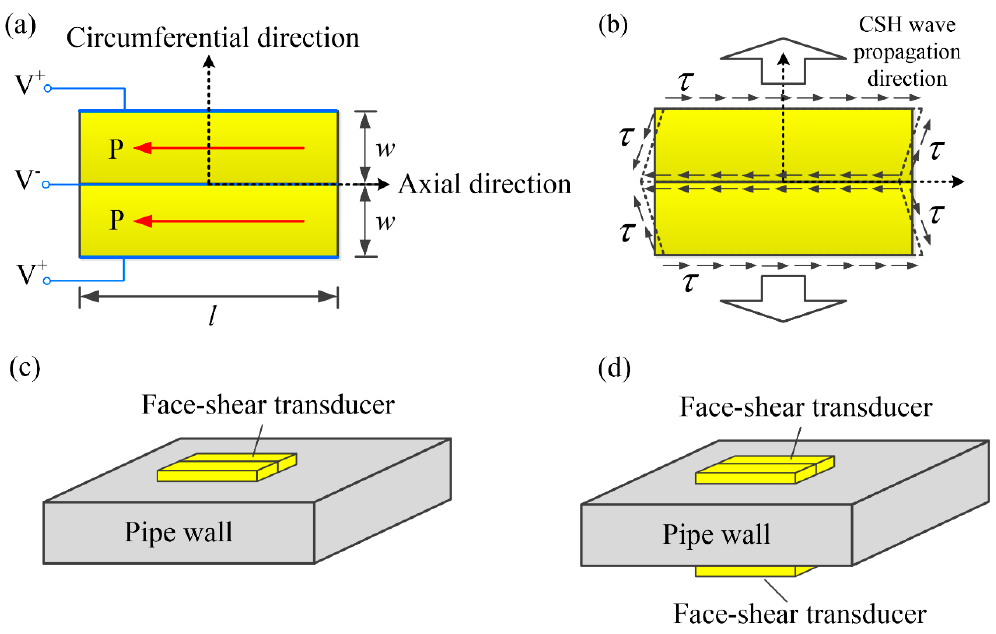
Figure 4. ( a ) Schematics of the proposed bidirectional CSH wave piezoelectric transducer, ( b ) bidirectional CSH wave driving mechanism, ( c ) single transducer configuration for pure CSH 0 wave excitation below the first cutoff frequency and ( d ) dual transducer configuration for selectively exciting CSH 0 or CSH 1 wave above the first cutoff frequency.